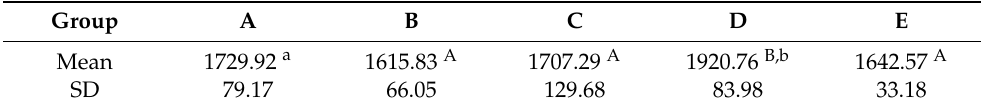
Table 5. Bodyweight of broiler chickens at 36 days of age (g).